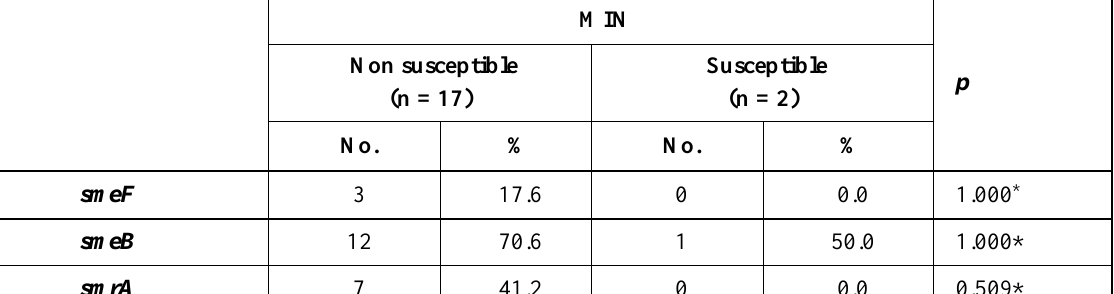
Table 6. Correlation between the over-expression of efflux pumps and resistance to